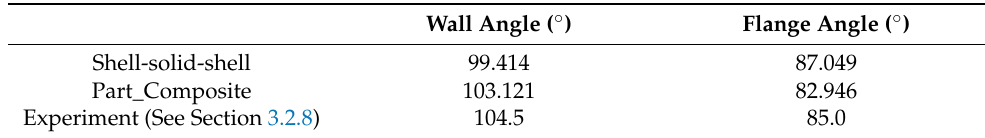
Table 8. Comparison of wall and flange angle for different modelling approach to experiment with